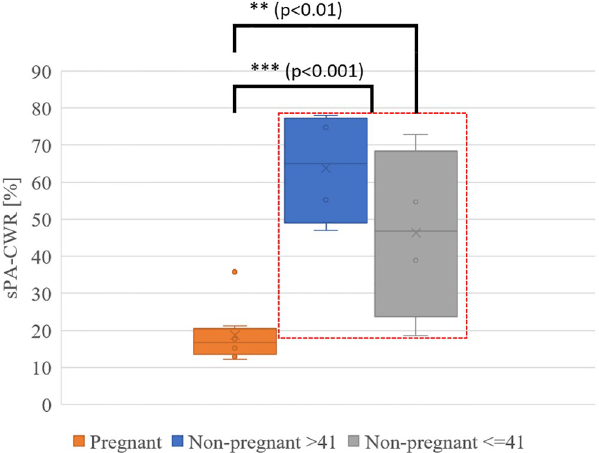
Fig 4. Spectroscopic photoacoustic (sPA) imaging estimated CWR in pregnant and non-pregnant � 41 year-old and in non-pregnant > 41 year-old cervix samples. The analysis of all cervix samples from non-pregnant and pregnant women showed a significantly lower CWR in the pregnant cervix (at-term). A subgroup analysis comparing pregnant women and non-pregnant women age � 41 years also indicated a significantly lower CWR in the cervix samples from pregnant